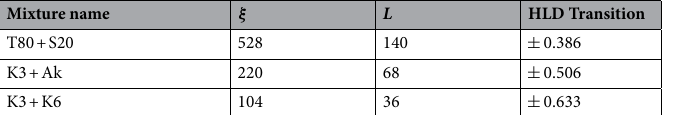
Table 3. HLD transition values predicted by ξ and L for the synthetic microemulsion system containing Mixures (1), (2), and